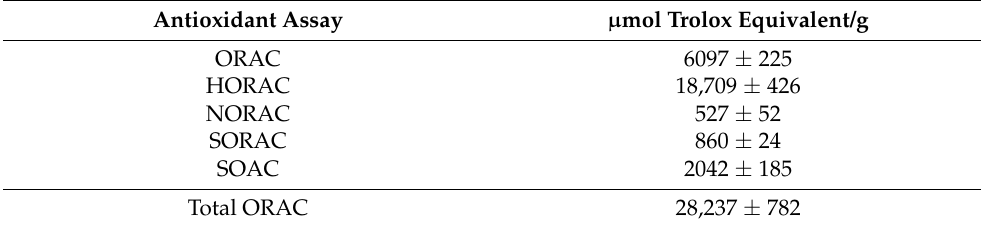
Table 4. Antioxidant analysis of WCCE. Results are expressed as µ mol Trolox equivalent/g ± SD. ORAC: oxygen radical absorbance